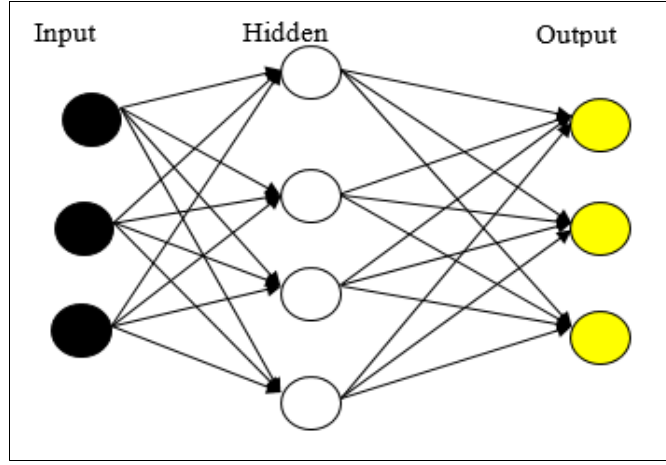
Figure 1: Feed Forward Neural